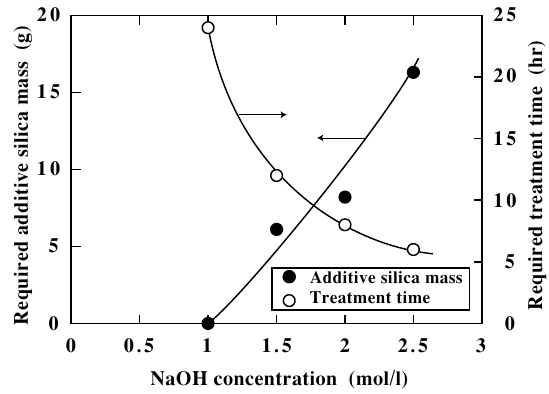
Fig. 13 Adsorption mass of NH 4 + for products synthesized under vari- ous experimental conditions.